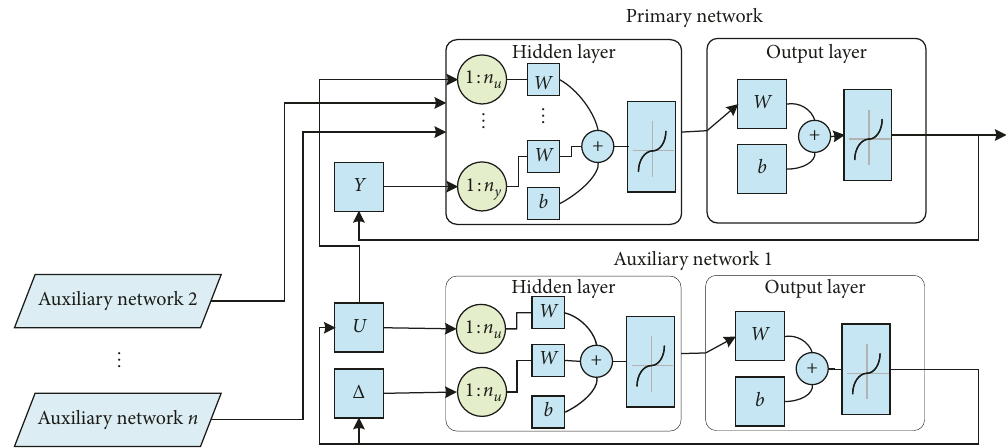
Figure 1: Compound autoregressive network for the multivariable time-series prediction.